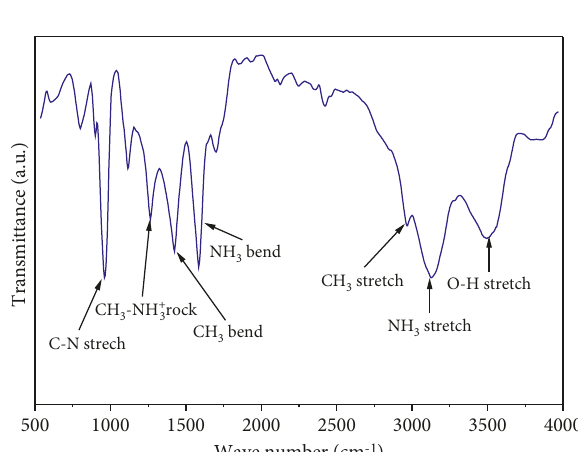
Figure 5: Absorbance and reflectance spectra of the MAPB thin